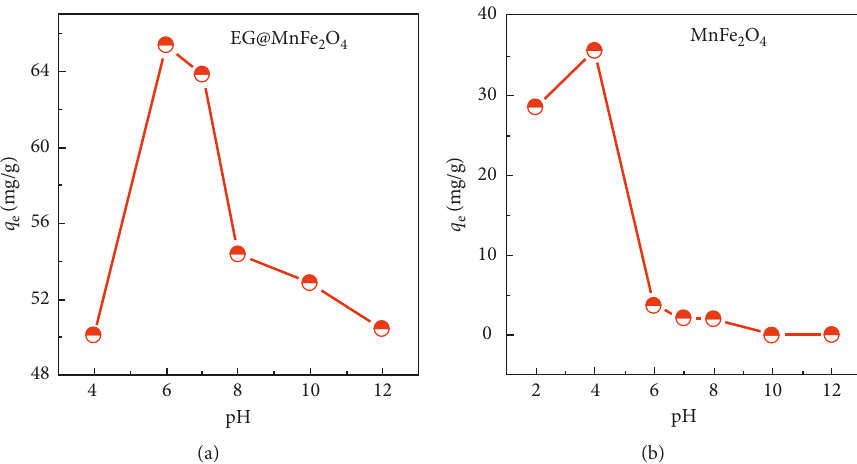
Figure 6: Effect of pH on the adsorption efficiency of CR over the EG@MnFe 2 O 4 (a) and MnFe 2 O 4 (b) materials. Experimental conditions included adsorbent dose of 0.5g/L, solution volume of 100mL, and dye concentration of 60mg/L at various pH (2–12). Experiments were run at room temperature (25 ° C) during 210min.